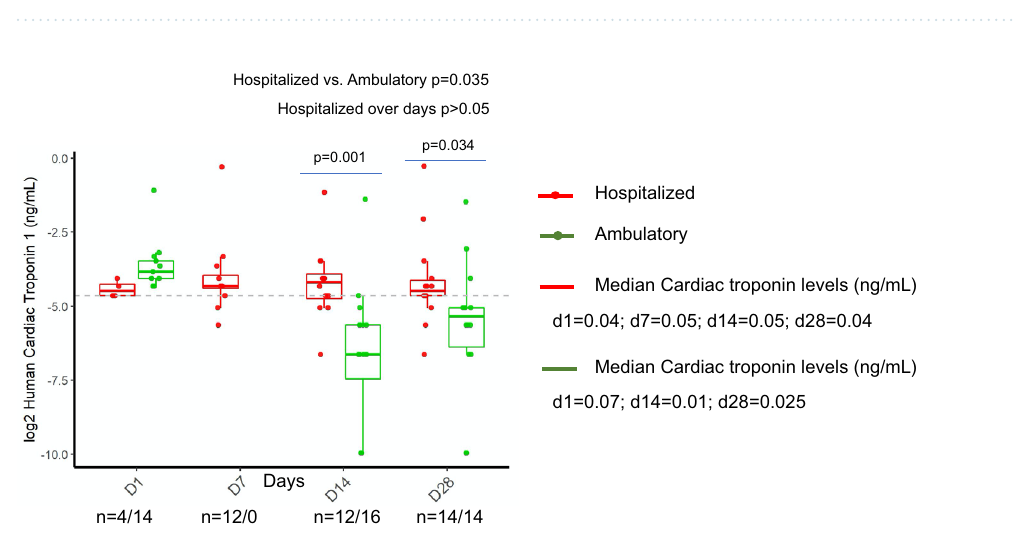
Figure 3. Longitudinal monitoring of ferritin levels in hospitalized and ambulatory COVID-19 patients. Figure was created using ggplot2 package version 3.3.0. supported on R program software 38 .